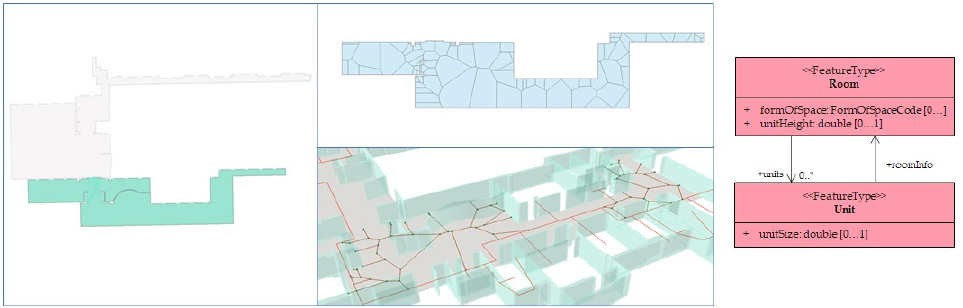
Figure 15. Level 3 network data representing pathways within a lobby.